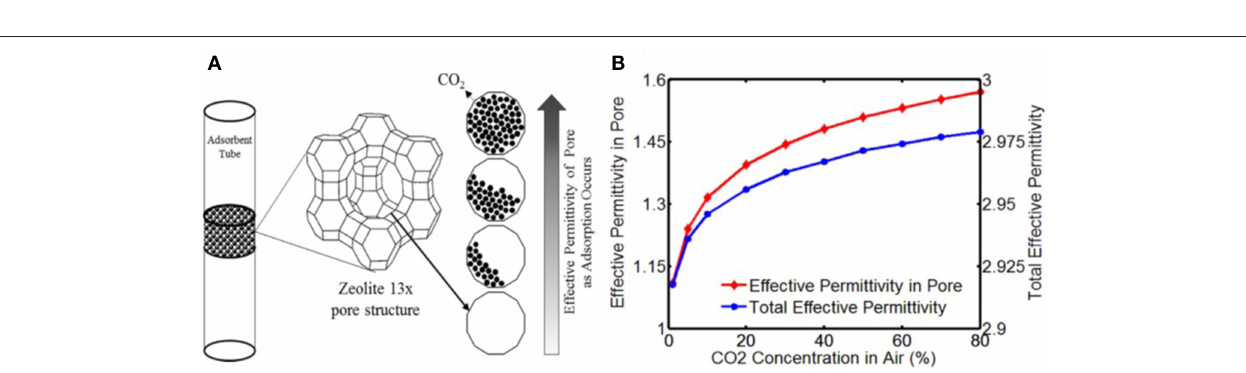
FIGURE 5 | (A) Evolution of CO 2 adsorption in Zeolite X and the corresponding permittivity change, (B) simulation results of concentration effect on permittivity of pores and adsorbents. Reproduced with permission from Zarifi et al. (2017). Copyright 2017